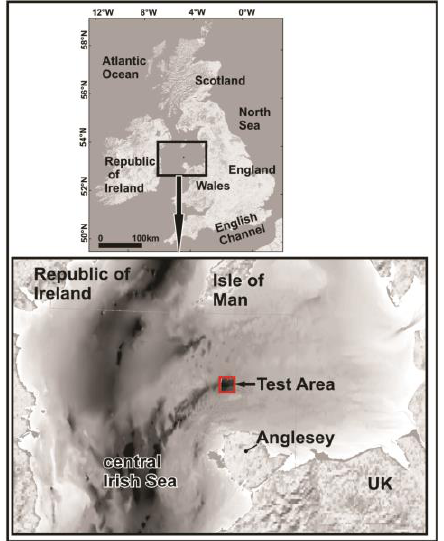
Figure2. Location of the submarine drumlin field in the